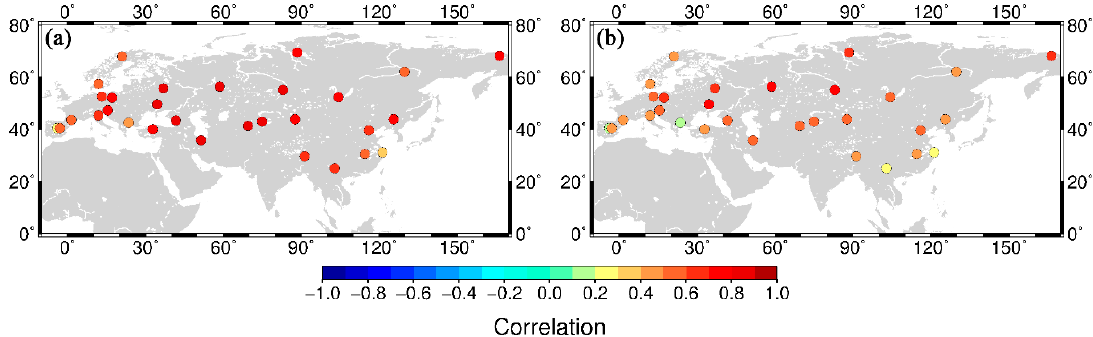
Figure 3. ( a ) Correlation between the GPS height and the AOH deformation; ( b ) Correlation between the GPS height residuals and AOH deformation residuals.